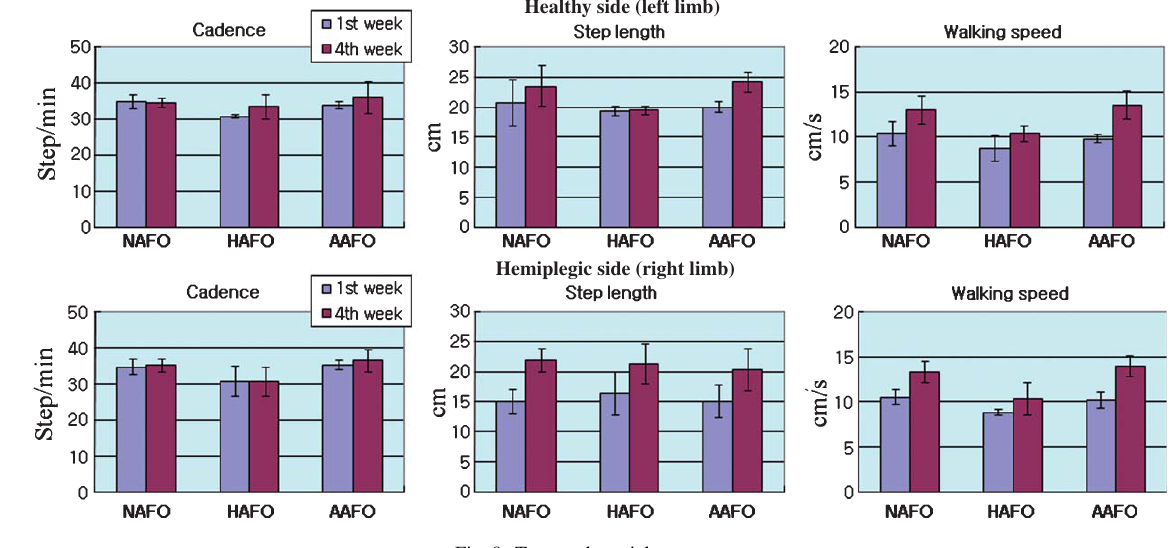
Fig. 8. Temporal-spatial